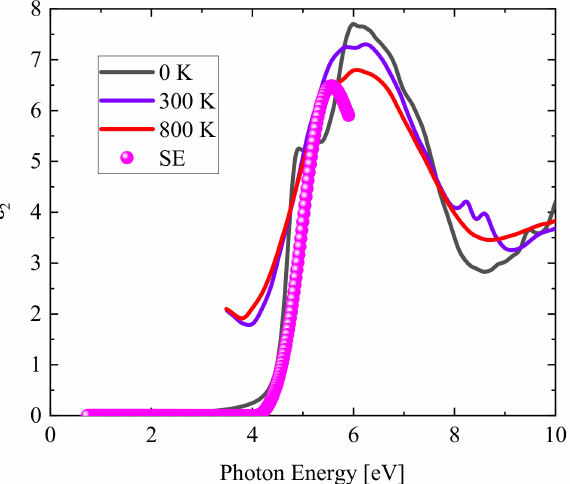
Figure 5. The theoretically predicted dielectric functions of Ta 2 O 5 at finite temperatures using first-principles calculations as compared with the SE